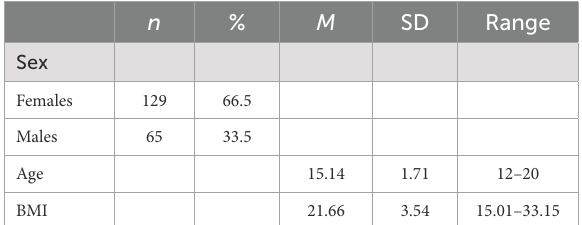
TABLE 1 Characteristics of study participants ( N =